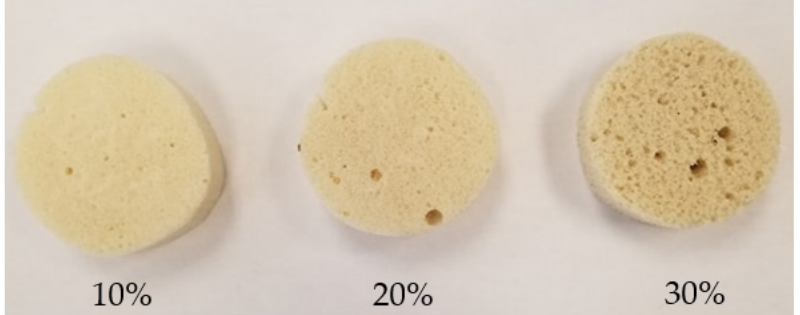
Figure 1. Numerical image of mechanically mixed foams with fine fiber at 10, 20, and 30%.